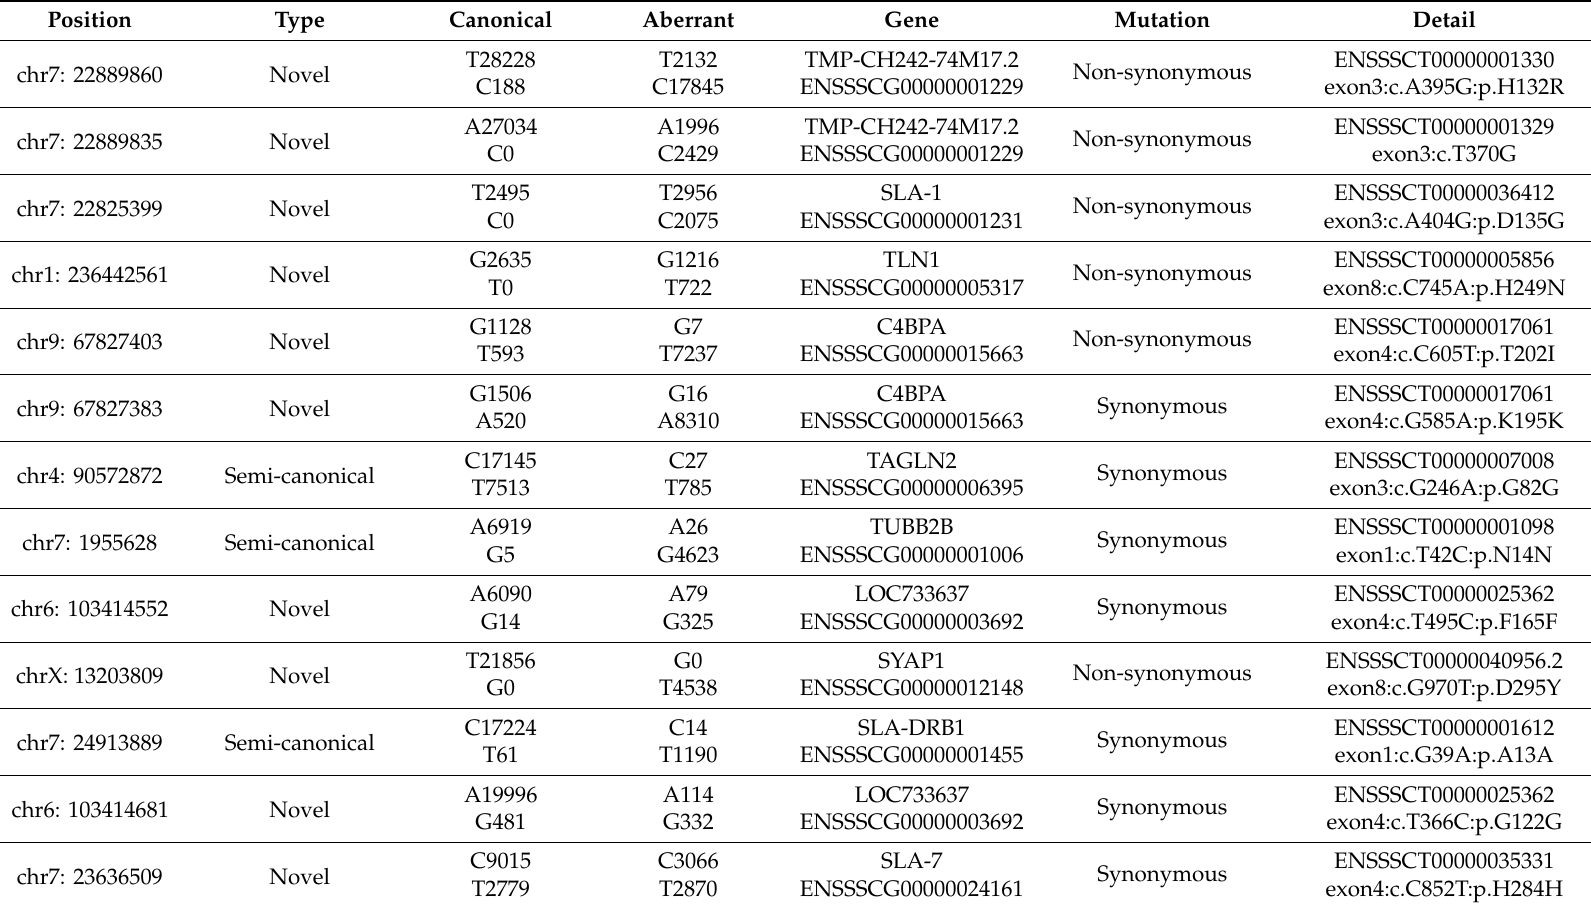
Table 2. Statistics of di ff erent SNP mutation types in di ff erent